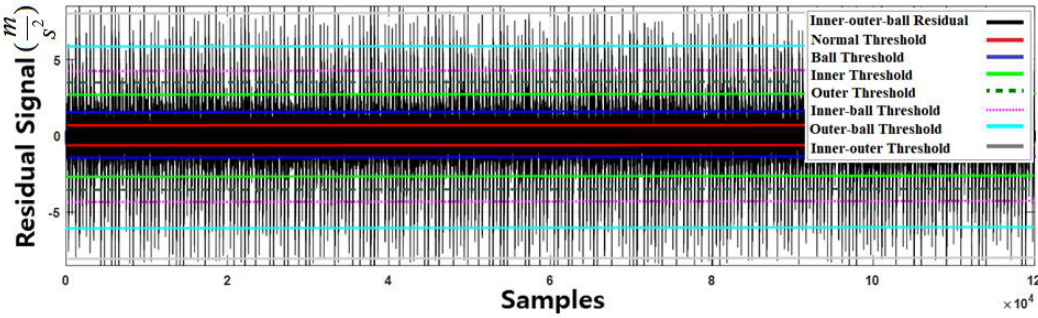
Figure 18. Residual signal for the inner-outer faulty condition, normal, ball, inner, outer, inner-ball, outer-ball, and inner-outer thresholds with a crack width of 6 mm.